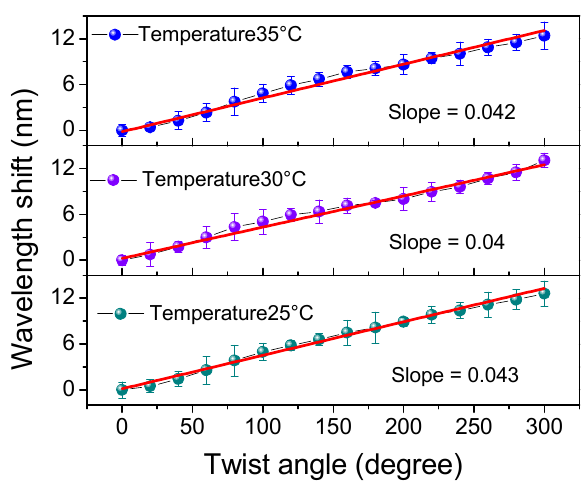
Figure 9. (a) Twist-induced lasing-wavelength shift and (b) response in the CW direction; (c) Twist- induced lasing-wavelength shift and (d) response in the ACW direction.